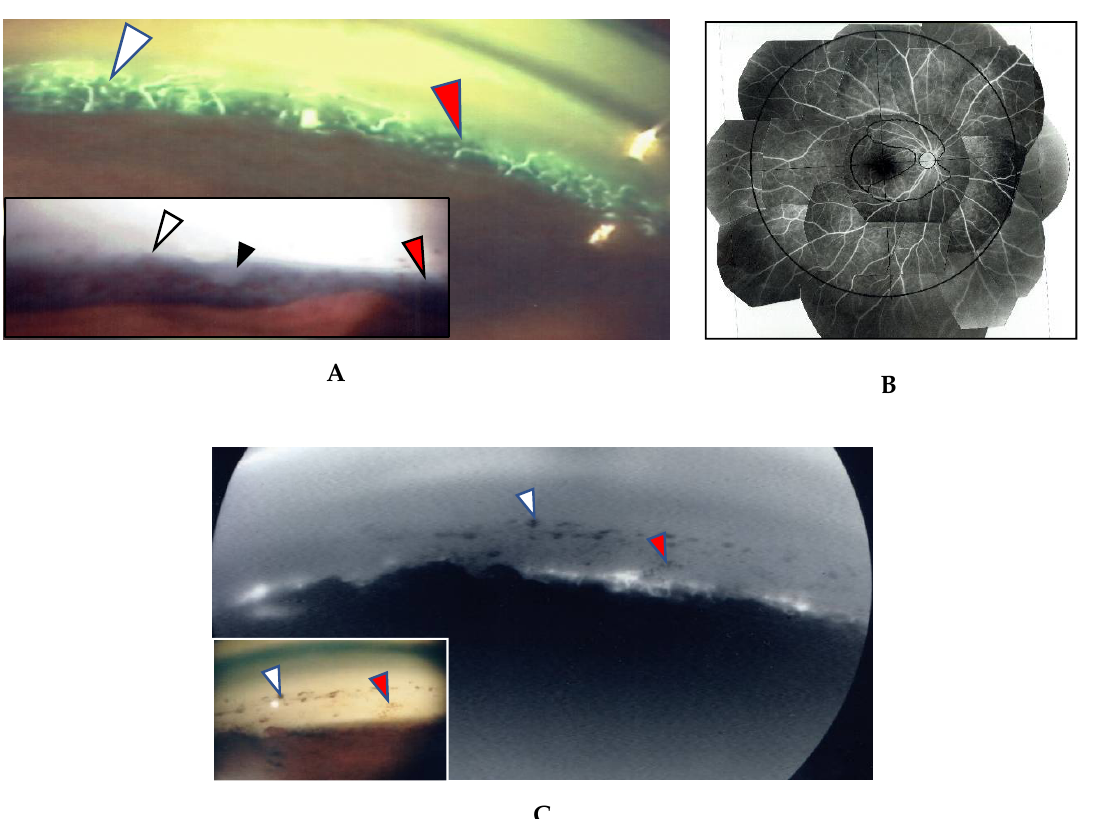
Figure 1. ( A,B ) Images of the right eye of Case 53, a 50-year-old female in Group III with a max intraocular pressure (IOP) of 14 mmHg. Photographs of fluorescein gonio angiography (FGA) and fundus fluorescein angiography (FFA) mounted on a transparent sheet showing different zones ( B ) and slit-lamp gonioscopy ( A , inset). A nodule can be seen at the ciliary body band (black arrowhead in A , inset). No topical betamethasone was prescribed prior to FGA and gonioscopy. The corresponding areas in A and A , inset are indicated by white and red arrowheads. Angle NVs can be seen arising perpendicularly from the iris root, and then changing their direction and running circumferentially along the trabecular meshwork; ( B ) Panoramic FFA image showing no non-perfusion area. The patient has had no recurrence of inflammation in both eyes for 18 years; ( C ) Fundus-camera images of FGA in the left eye of Case 23, a 72-year-old male in Group I with a max IOP of 35 mmHg. ( C , inset) Slit-lamp image showing no nodule. Topical betamethasone had been irregularly prescribed. The corresponding areas in C and C , inset are indicated by white and red arrowheads.